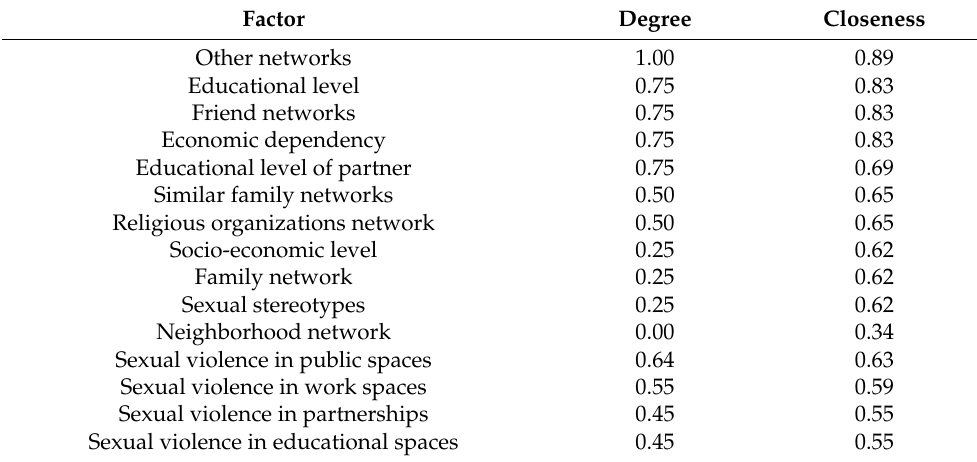
Table 6. Risk network indicators of degree centrality and proximity of the